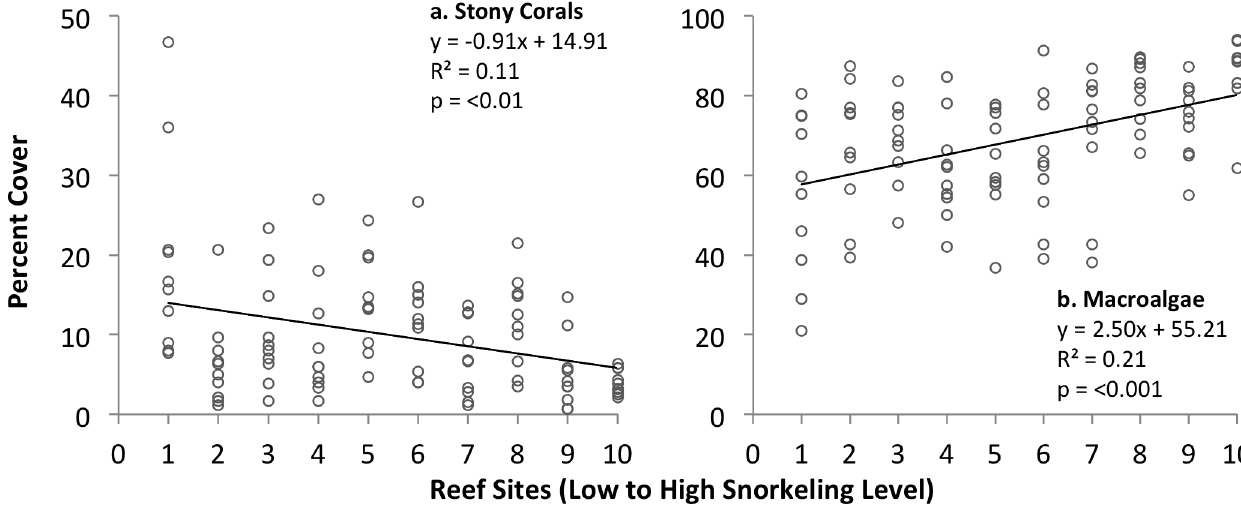
Fig 3. Variation in the percent cover of stony corals (left) and macroalgae(right) among patch reefs ranked by level of snorkeling in Akumal Bay, Mexico. N = 10 transects examinedper reef.